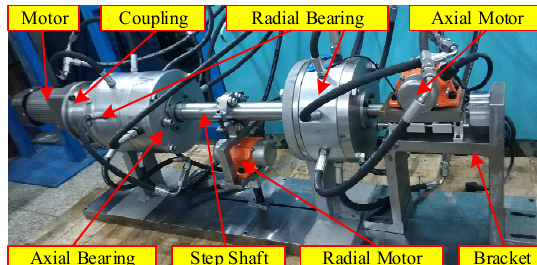
Figure 1. MLDSB Test Table.